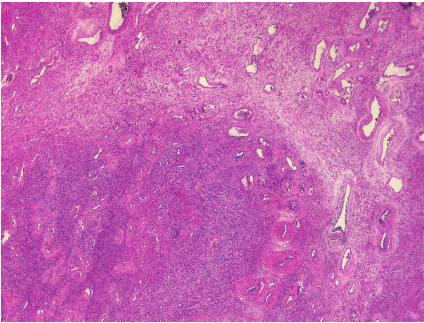
Figure 3: Prostatic tissue next to